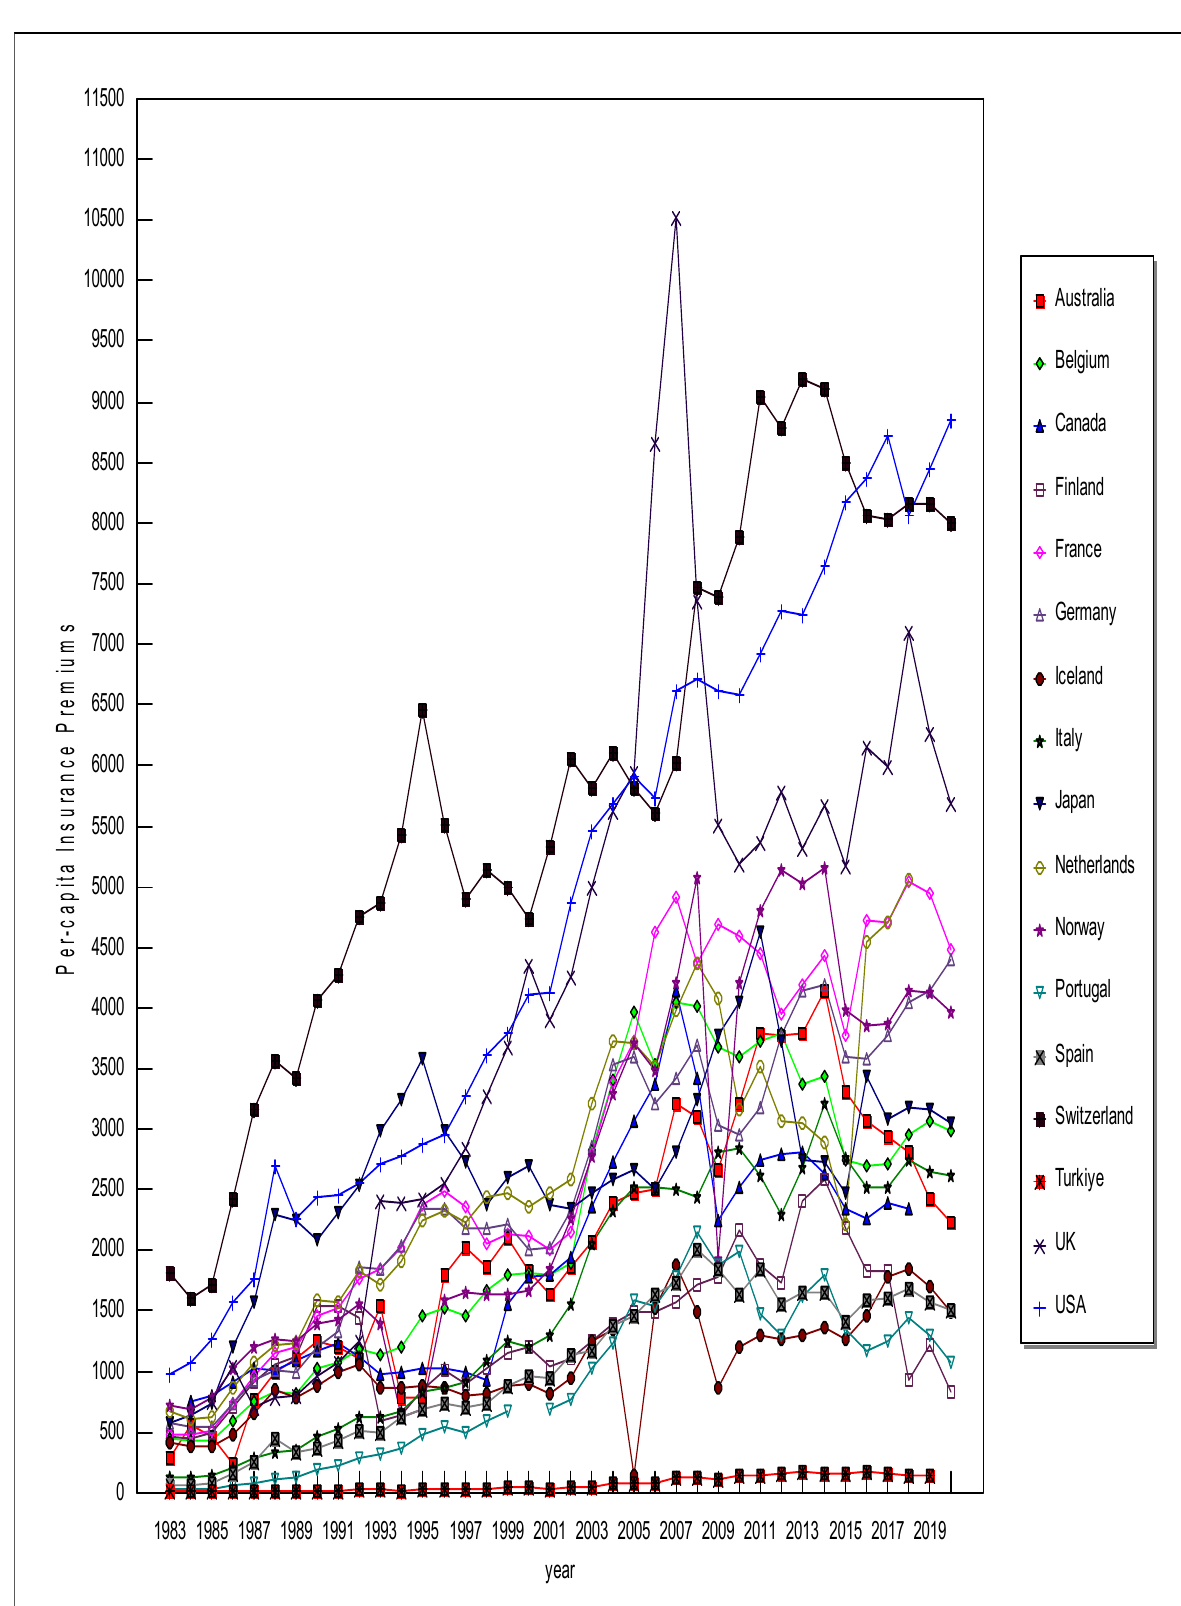
Figure 3. Per-capita Insurance Premiums for the countries with continuous data from 1985 to 2020.